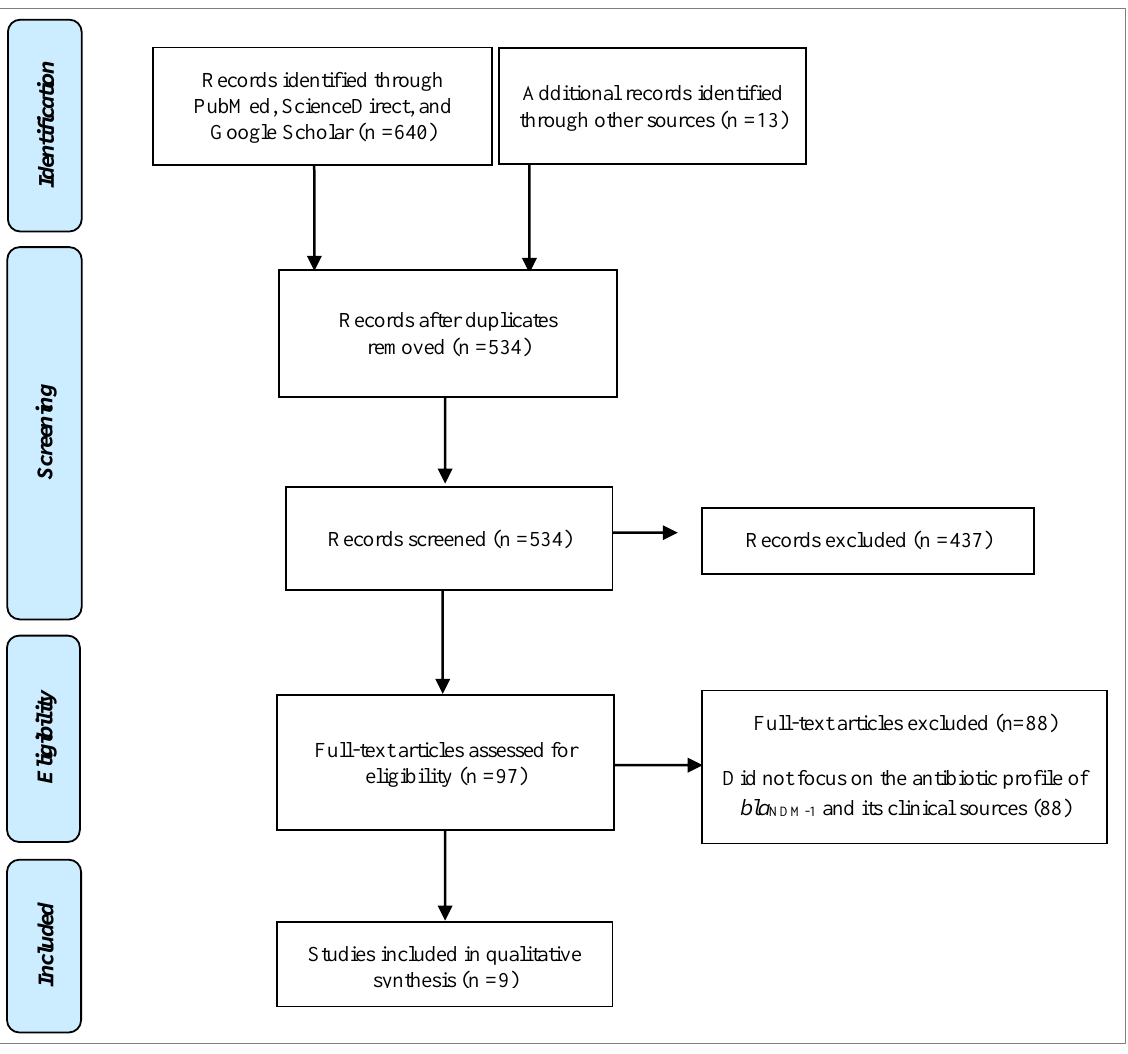
Figure 1. PRISMA flow diagram of study selection